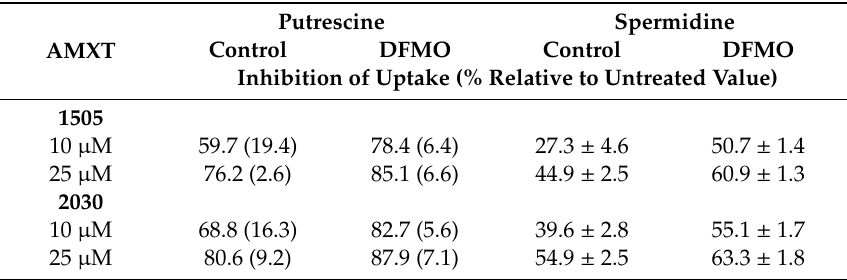
Figure 3. Molecular structure of the polyamine transport inhibitors AMXT 1505 and 2030 [14]. Table 4. The e ff ect of AMXT compounds on